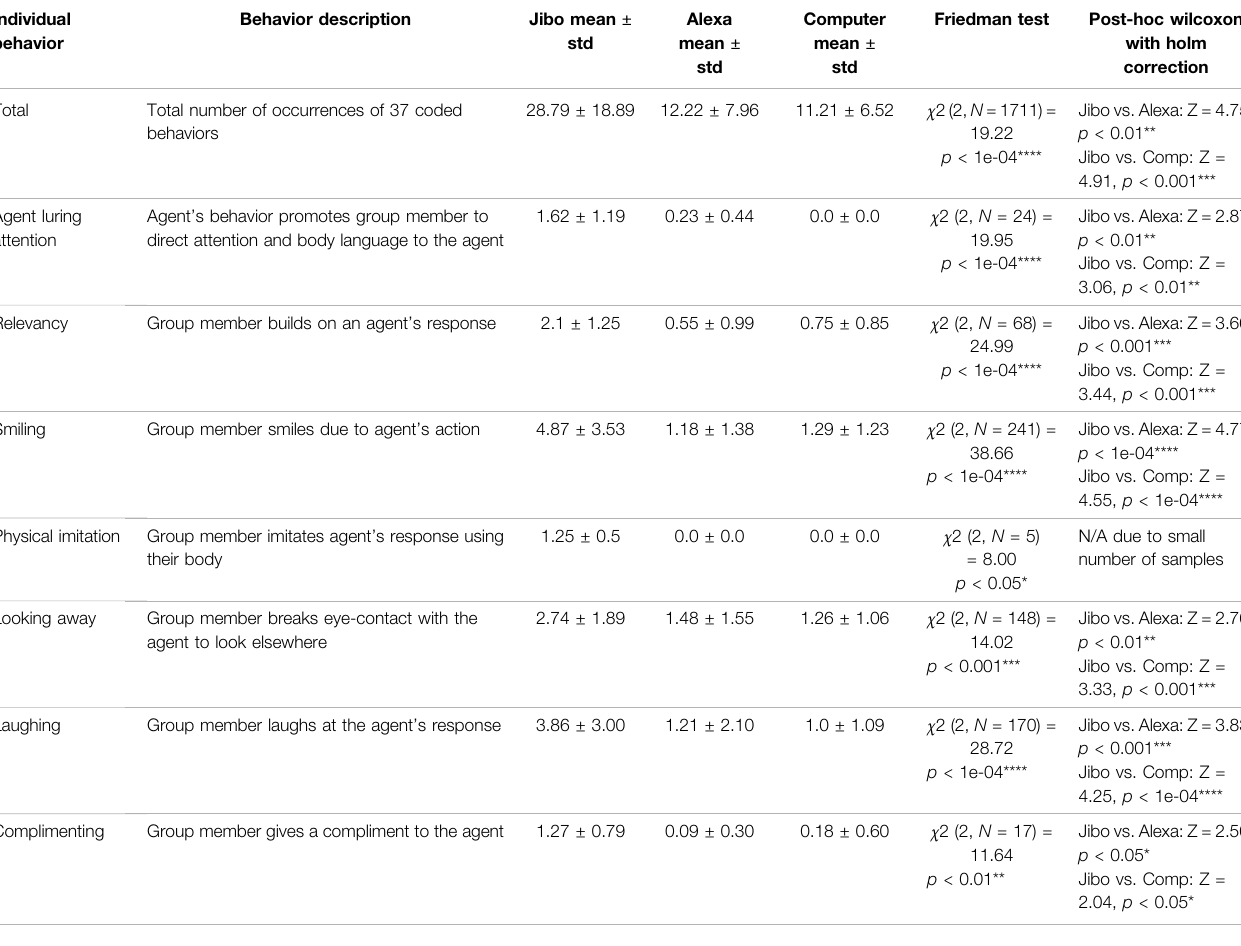
TABLE 1 | Comparing reciprocal behaviors observed around the three VUI agents that vary in the degree of social embodiment. The overall result across the combined 37 coded behaviors and the seven behaviors that showed statistically signi fi cant difference between the agents are highlighted. Individual behavior